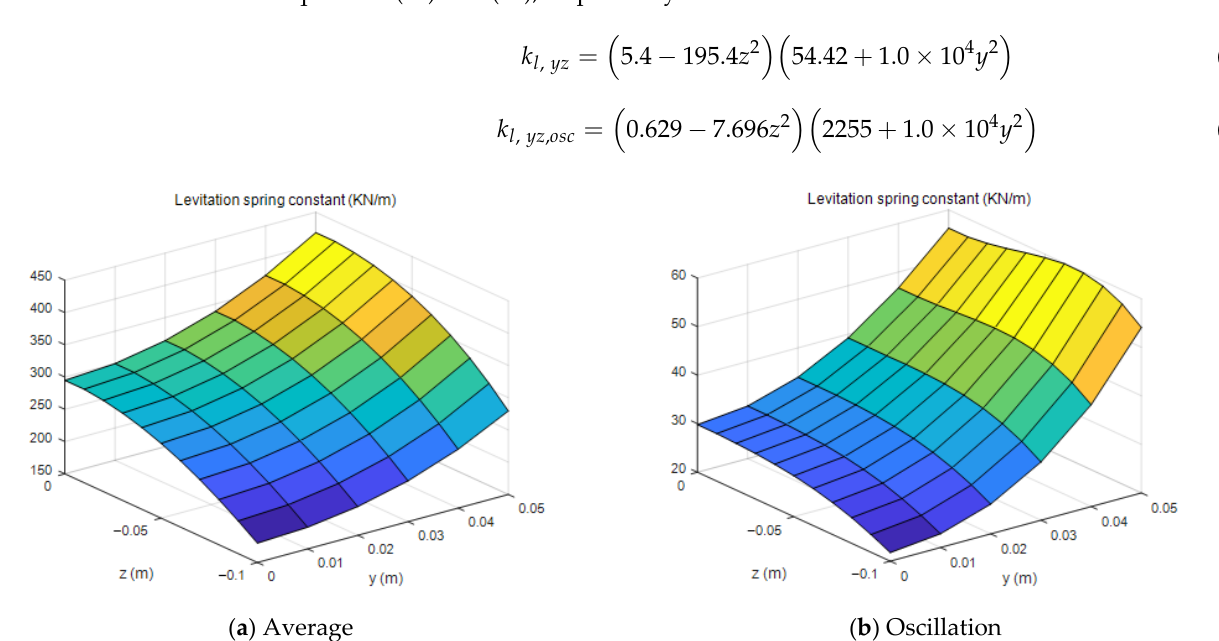
Figure 10. Levitation stiffness with respect to vertical and lateral positions.